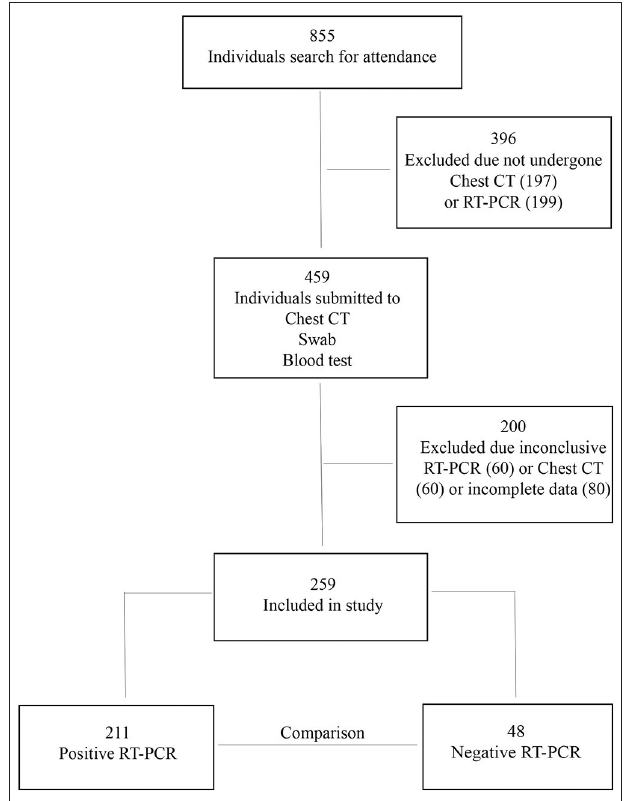
FIGURE 1 | Flowchart of the